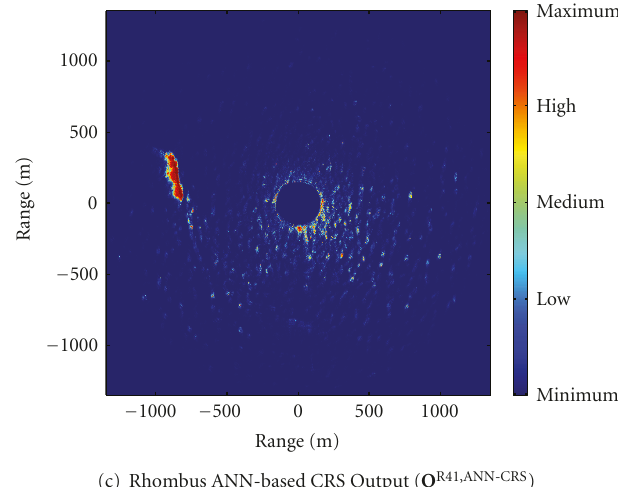
not only do not warrant an increase of the performance improvement but also increase the performance